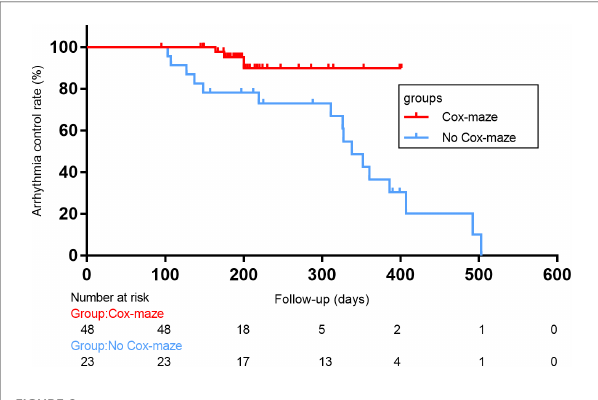
FIGURE 2 Arrhythmia control rates (including patients with successful AADs conversion)after concomitant Cox-maze IV procedure with surgical aortic valve replacement in patients with CAVD and AF. Log-rank statistic 6.281, p =0.012.